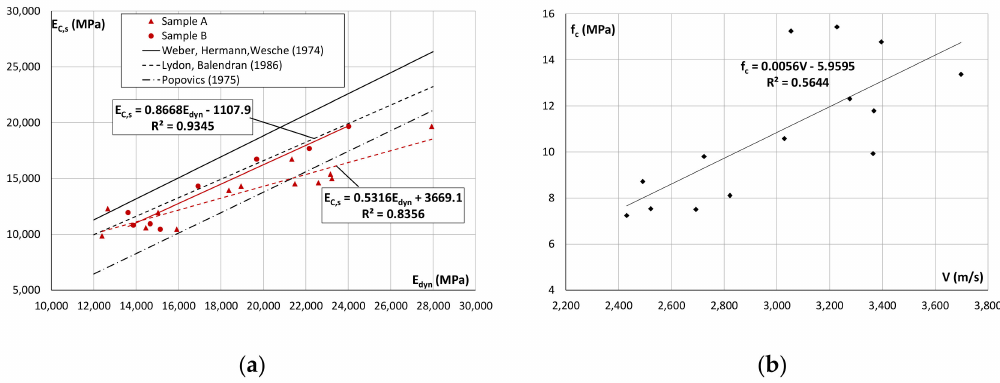
Figure 4. ( a ) Correlation laws between E dyn and E c,s ; ( b ) regression line between V and f c for Sample